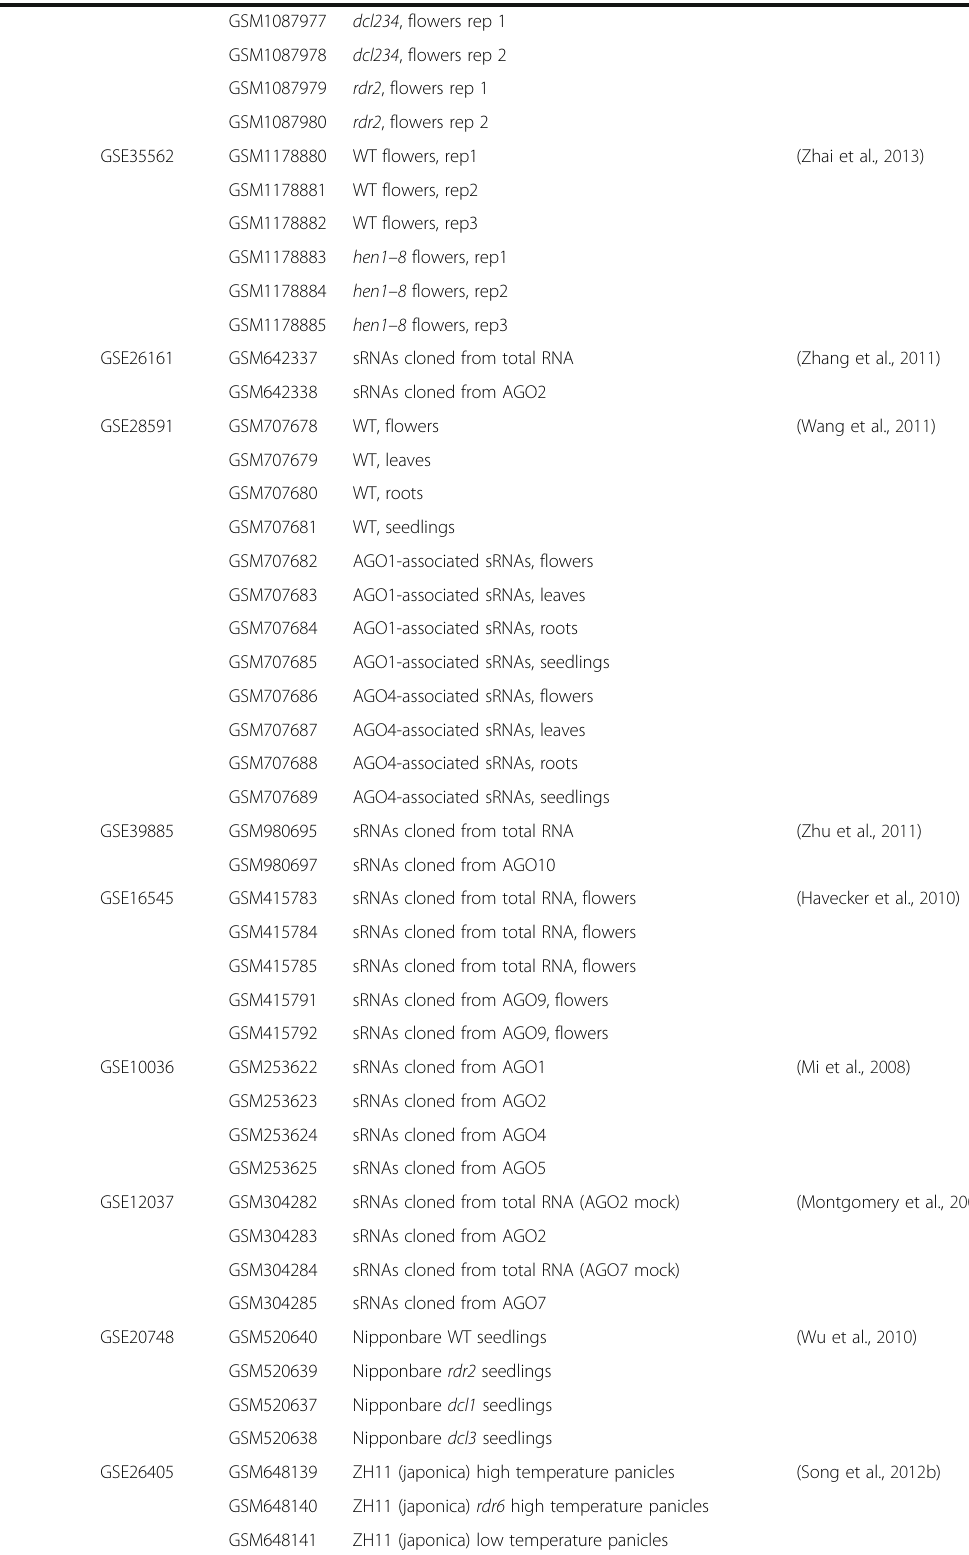
Table 3 List of sequencing data for plant small RNA research